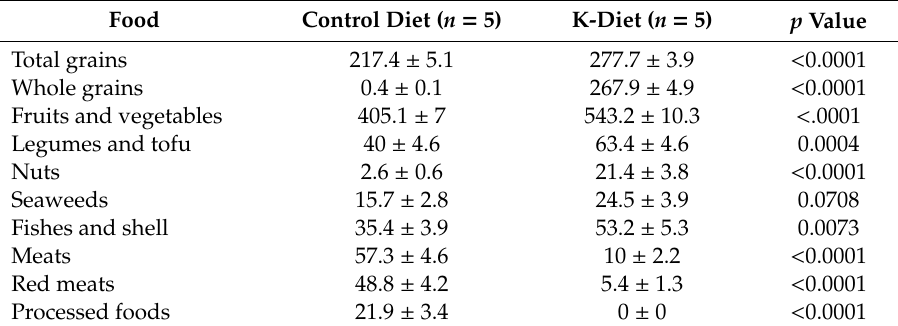
Table 5. Comparison of food consumption between control and K-diet